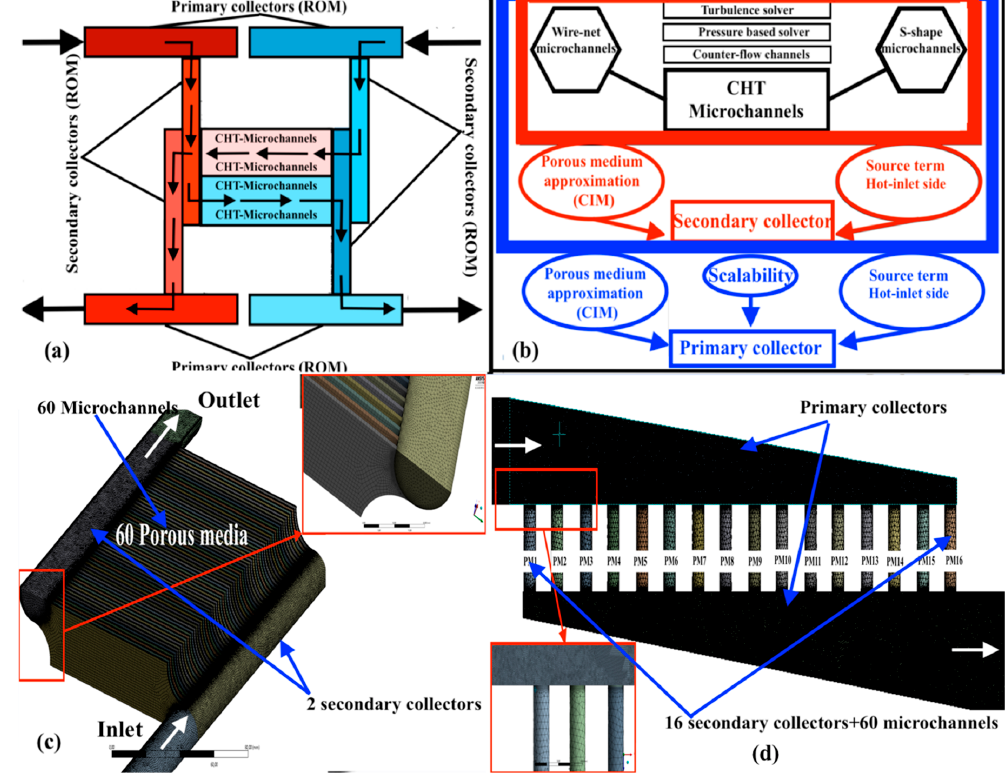
Figure 2. Scheme of the heat exchanger assembly ( a ); numerical methodology ( b ); secondary collector model ( c ); primary collector mesh model with 16 porous mediums replicating 16 collectors ( d ).